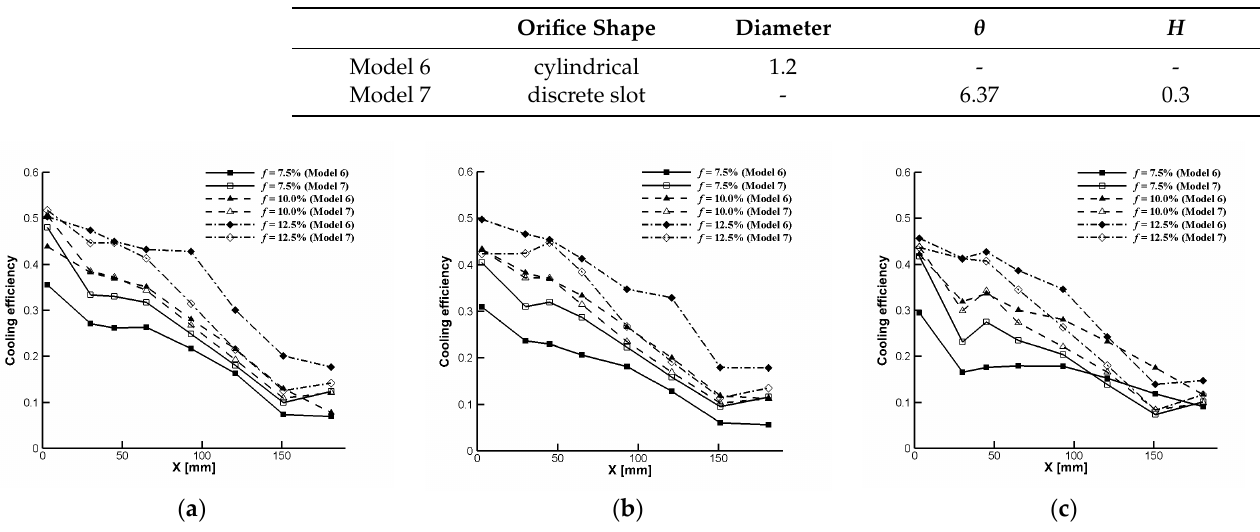
Table 5. Structural parameters of film orifices.